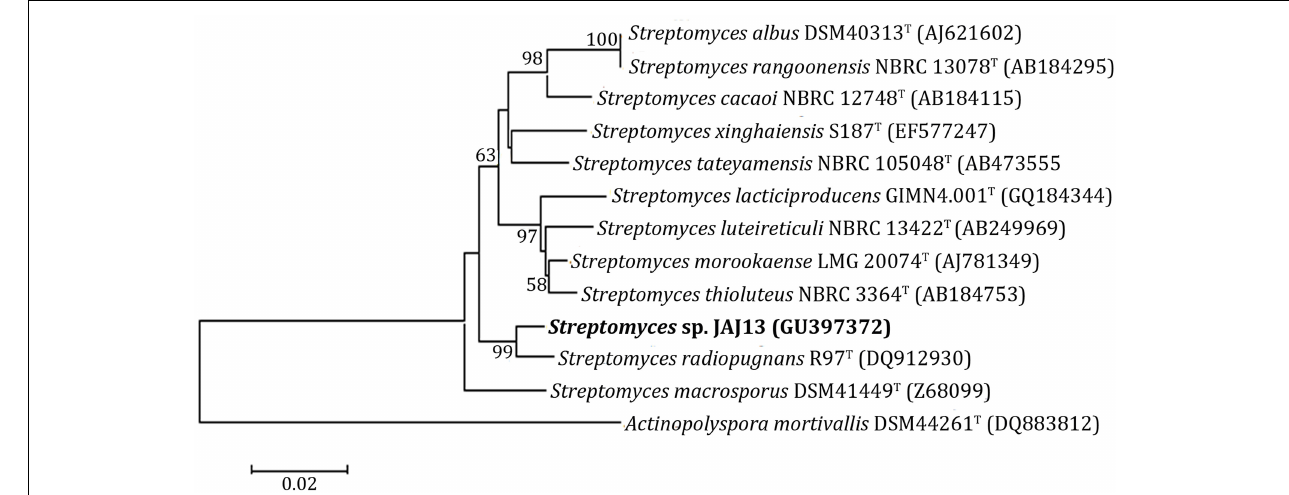
as out-group. Numbers at nodes indicate the levels of bootstrap support (%) based on a neighbor-joining analysis of 1000 resampled datasets; only values above 50% are shown. Score bar represents 0.01 substitutions per site.